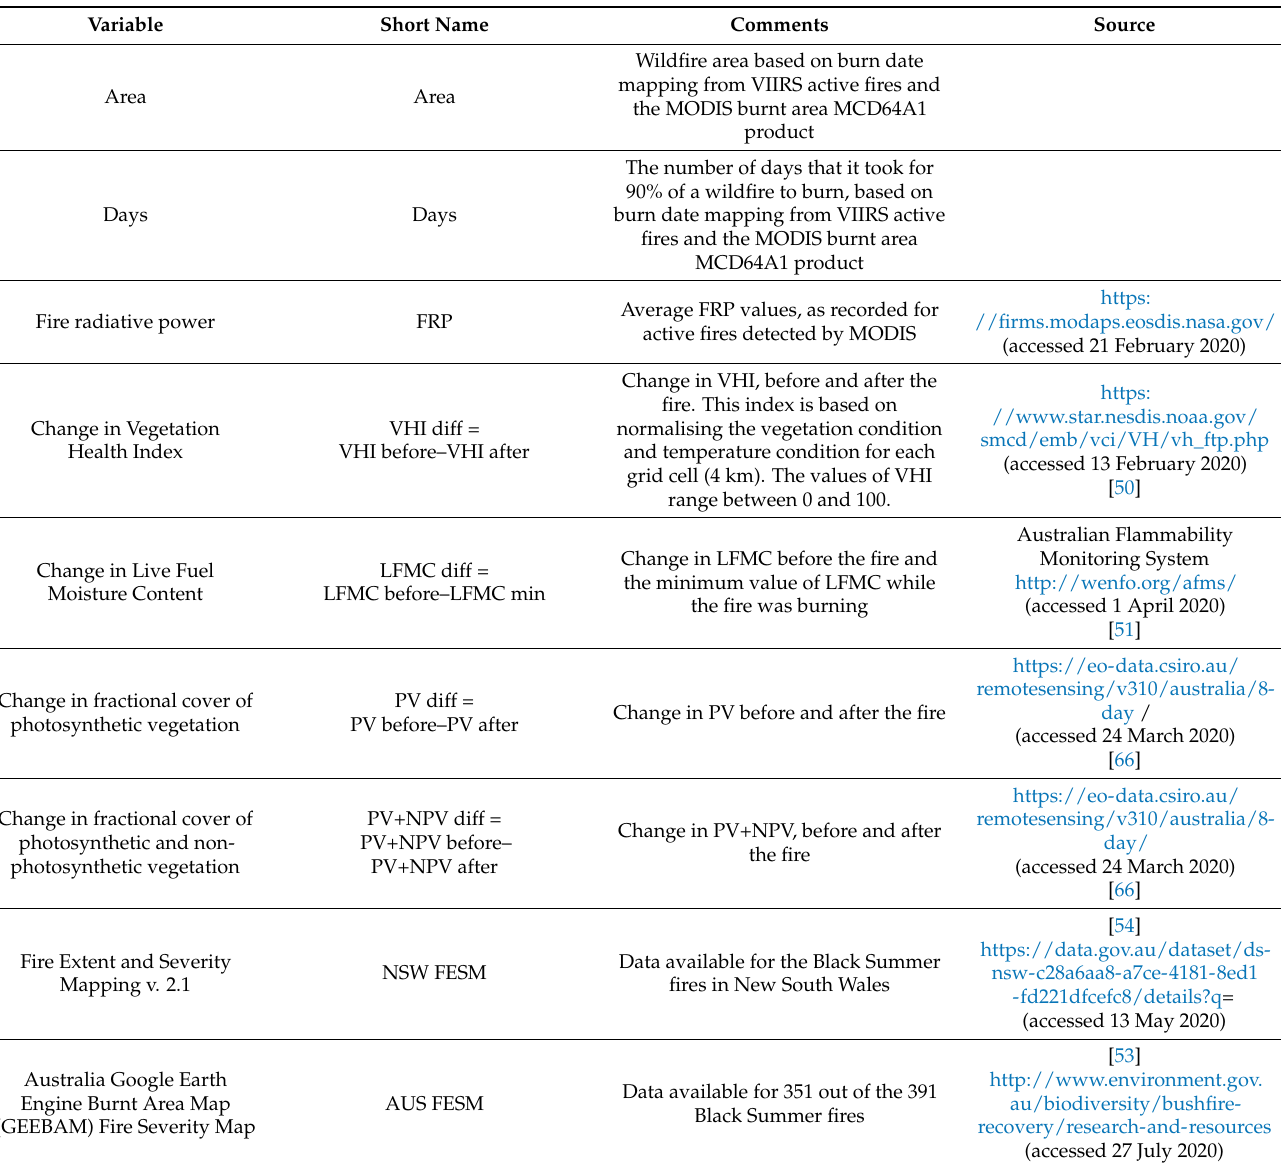
Table 1. The response variables used in this